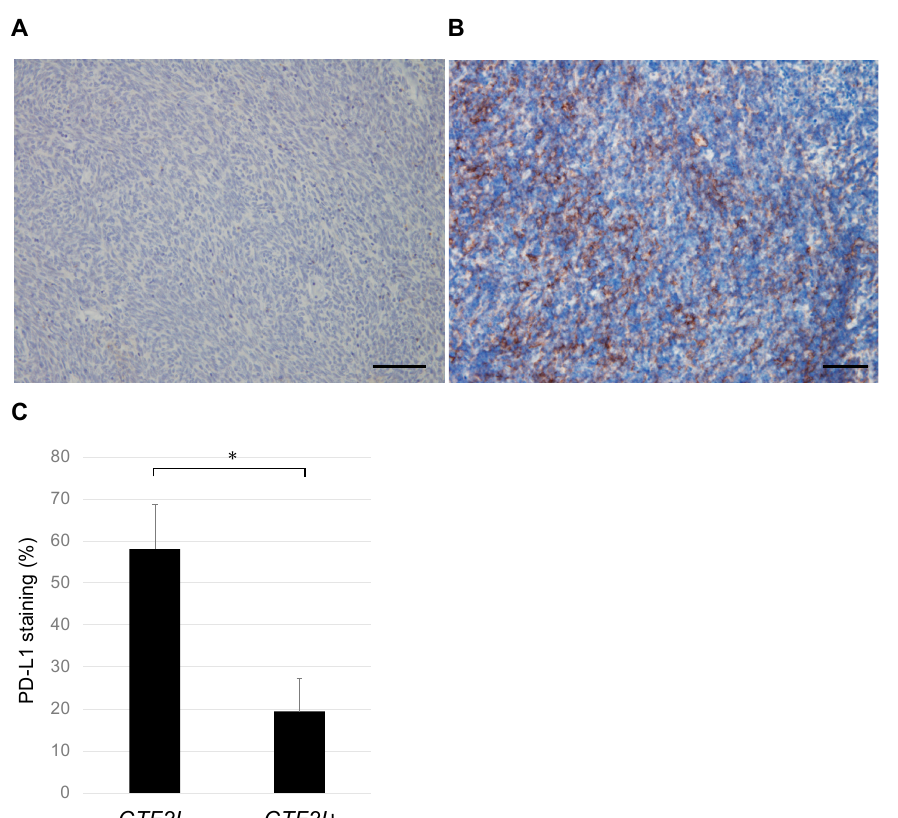
Figure 2. Immunostaining for PD-L1 in thymomas with and without mutant GTF2I . ( A ) A representative thymoma with mutant GTF2I (Case 1, type A) shows weak staining for PD-L1. ( B ) A representative thymoma without mutant GTF2I (Case 15, type B1) shows relatively strong PD-L1 expression. Each scale bar indicates 100 µ m. ( C ) The PD-L1 levels were significantly higher in thymomas without mutant GTF2I . *, p < 0.05.